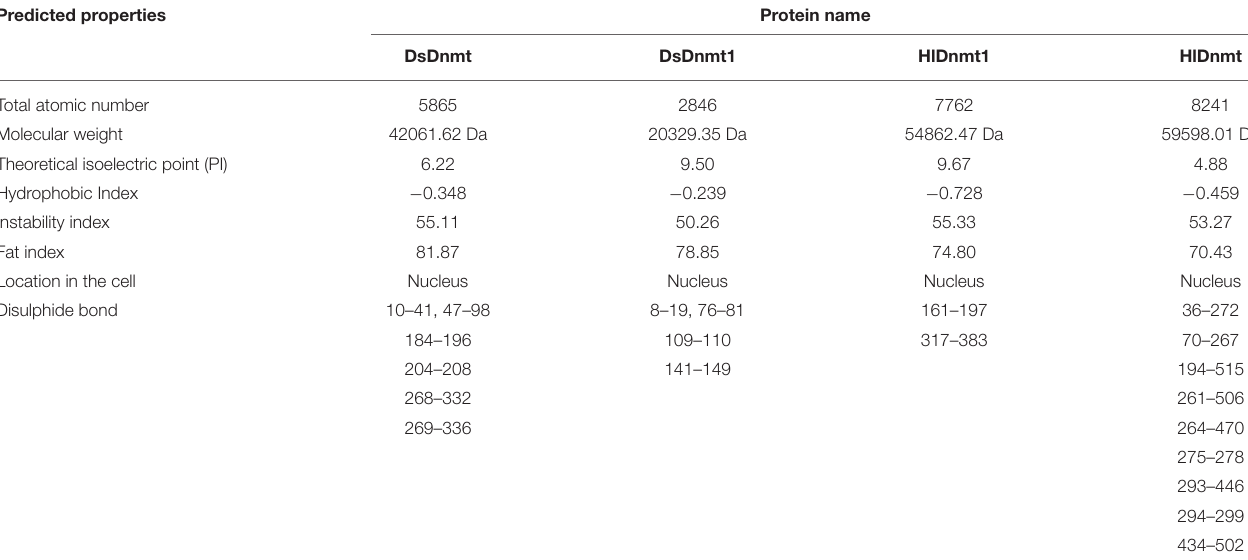
TABLE 2 | Predicted properties of the DNA methyltransferase protein of Dermacentor silvarum and Haemaphysalis longicornis